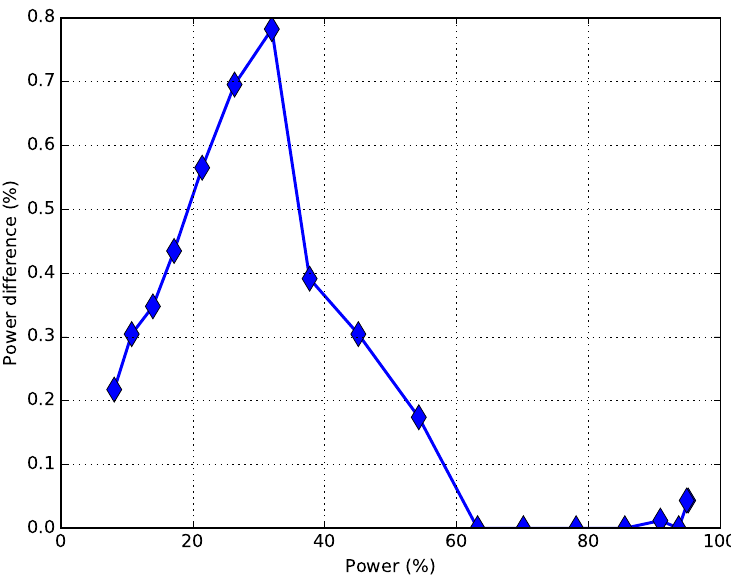
Figure 7. Simulated power differences between the pre- and post-upgrade